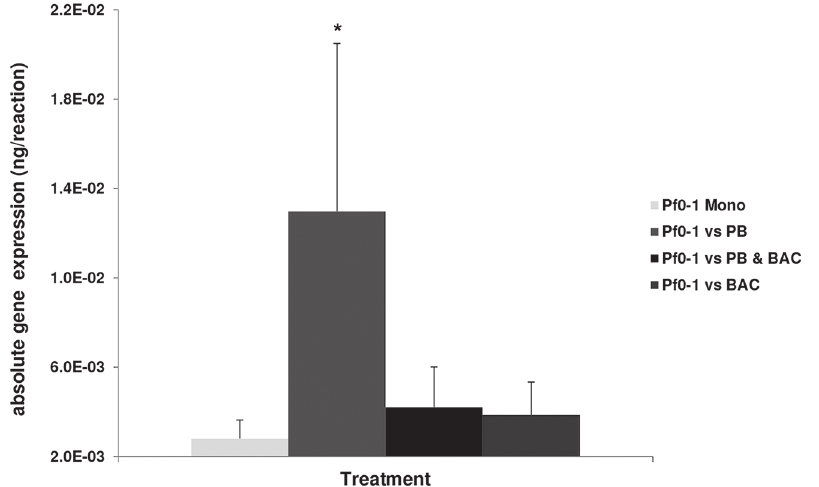
Fig 4. qRT-PCR results representing absolute gene expression of gene cluster Pf0-1_3463 obtained at day 6 (nutrient rich media). Error bars are indicating standard deviation (SD) between the triplicates. Significant differences between the qRT-PCR based gene expression by Pf0-1 in monocultures and mixed cultures is indicated by an asterisk (p (cid:3) 0.05).